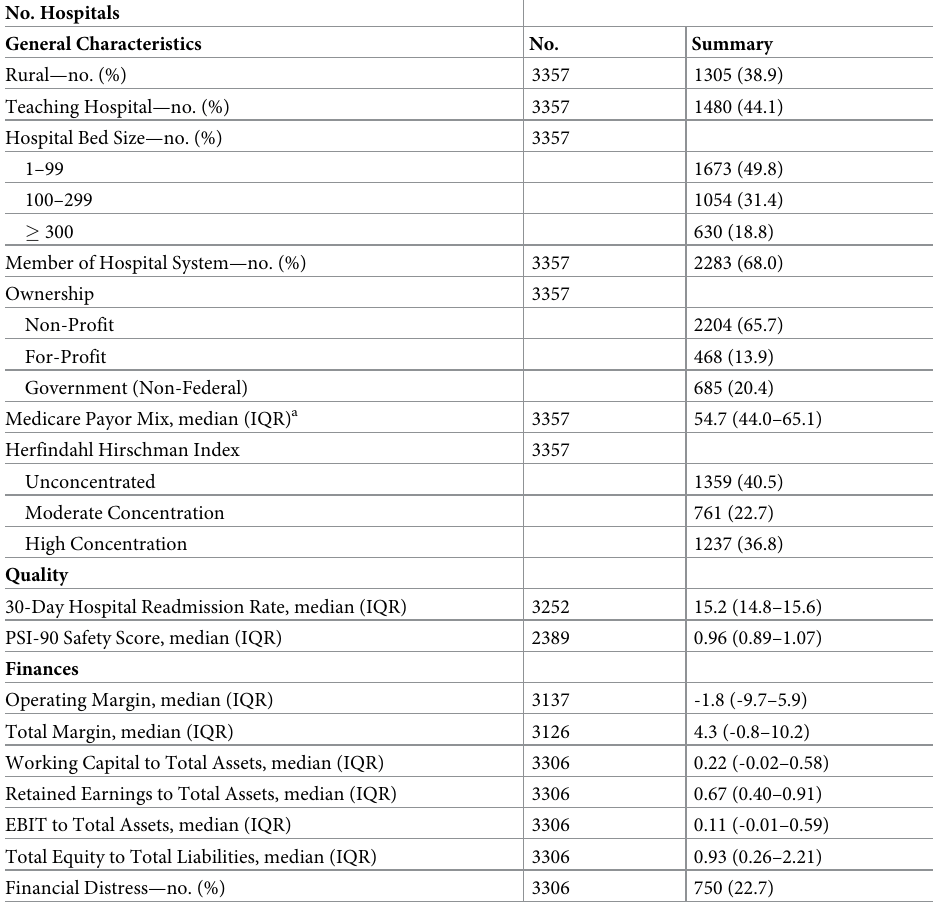
Table 1. General characteristics of hospitals in